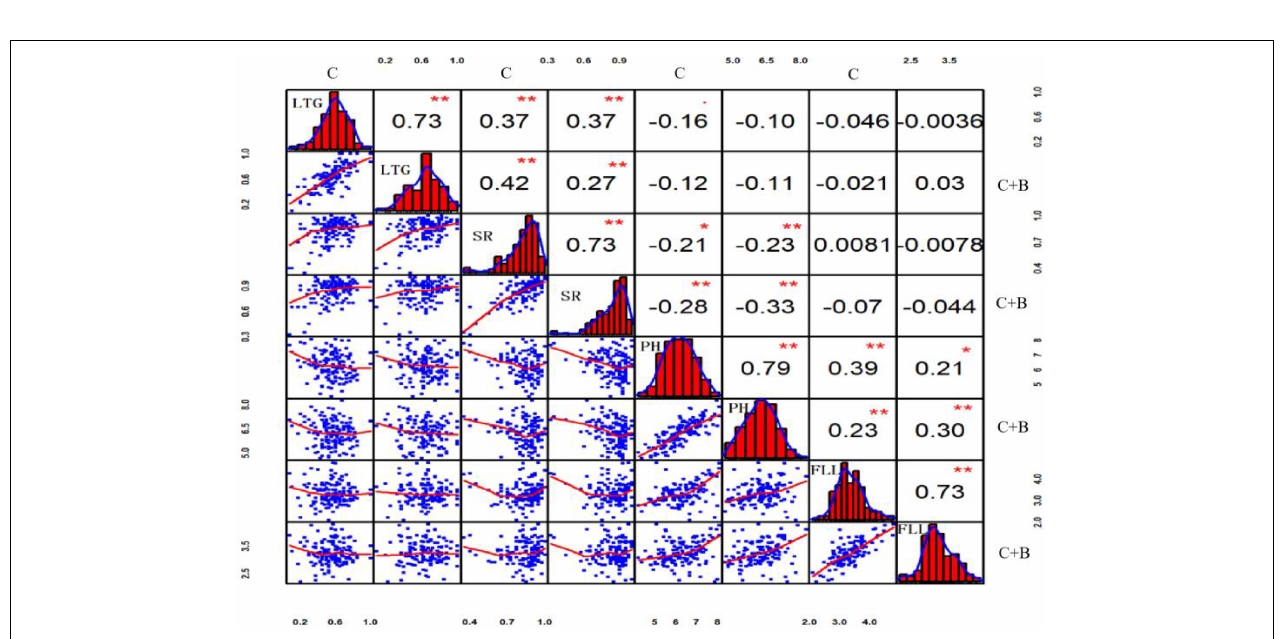
FIGURE 3 | Correlation analysis of LTG, SR, PH, and FLL under cold stress and BR-combined cold treatment. Plots on the diagonal line show phenotypic distribution of each trait as indicated; values above diagonal line are Pearson’s correlation coefficients between traits; plots below diagonal line are scatter plots of compared traits. ** P ≤ 0.01; * P ≤ 0.05. LTG, low-temperature germination rate; SR, survival rate; PH, plant height; FLL, first leaf length; C, cold stress; C + B, BR-combined cold treatment.